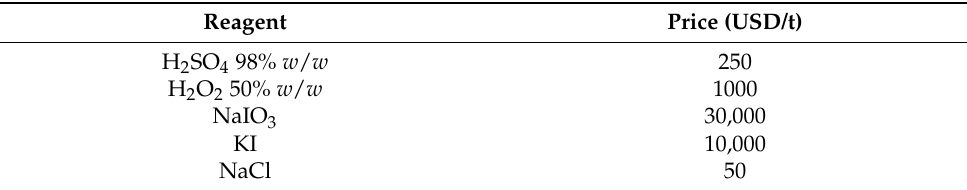
Table 6. Reagent prices used in the economic evaluation.